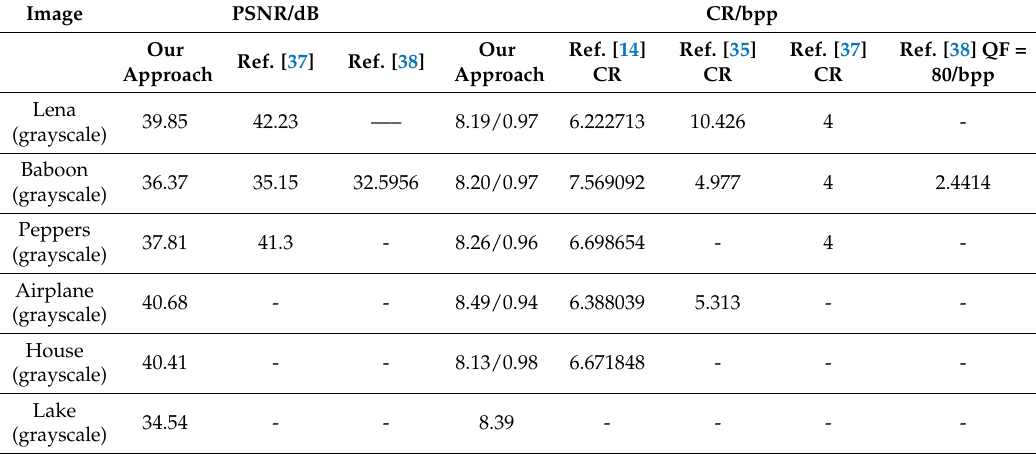
Table 1. CR and PSNR values of our approach and the compared